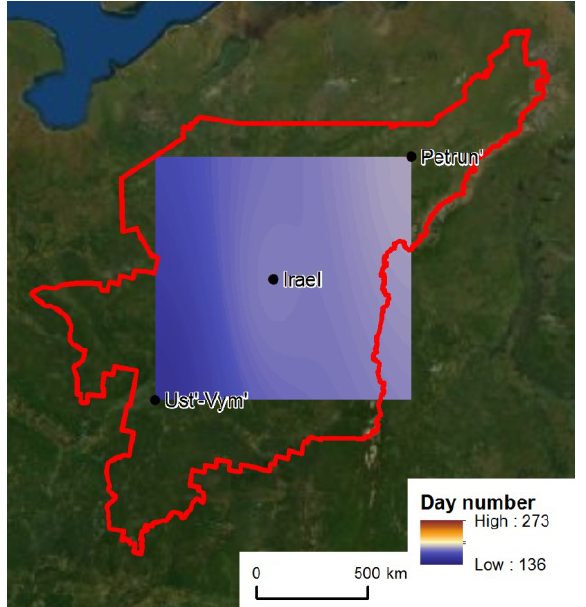
Figure 8. Ending days of spring growing season interpolated between meteorological